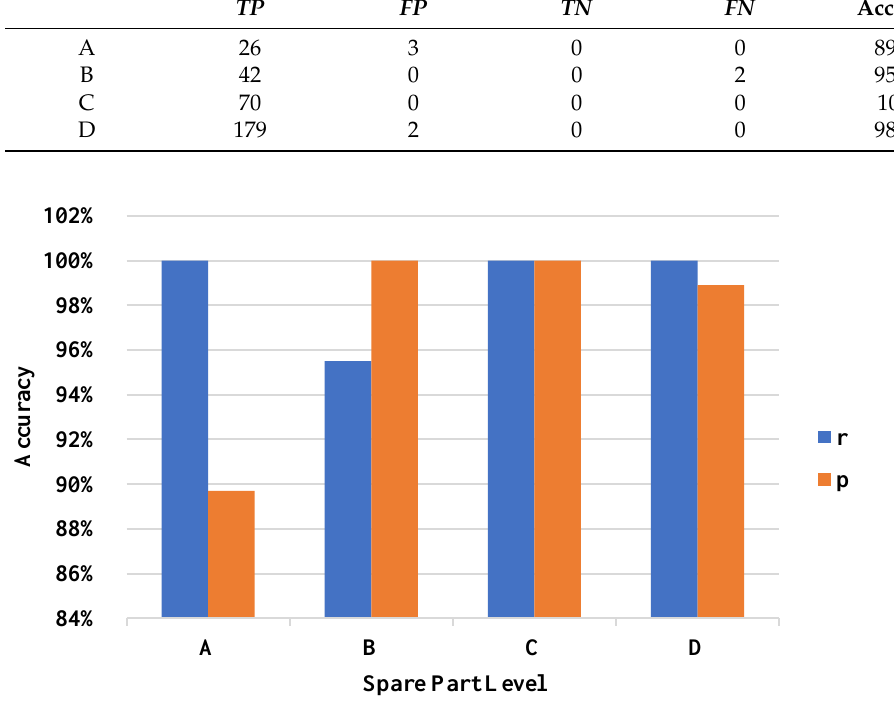
Figure 13. Results of r and p for semi-supervised learning.